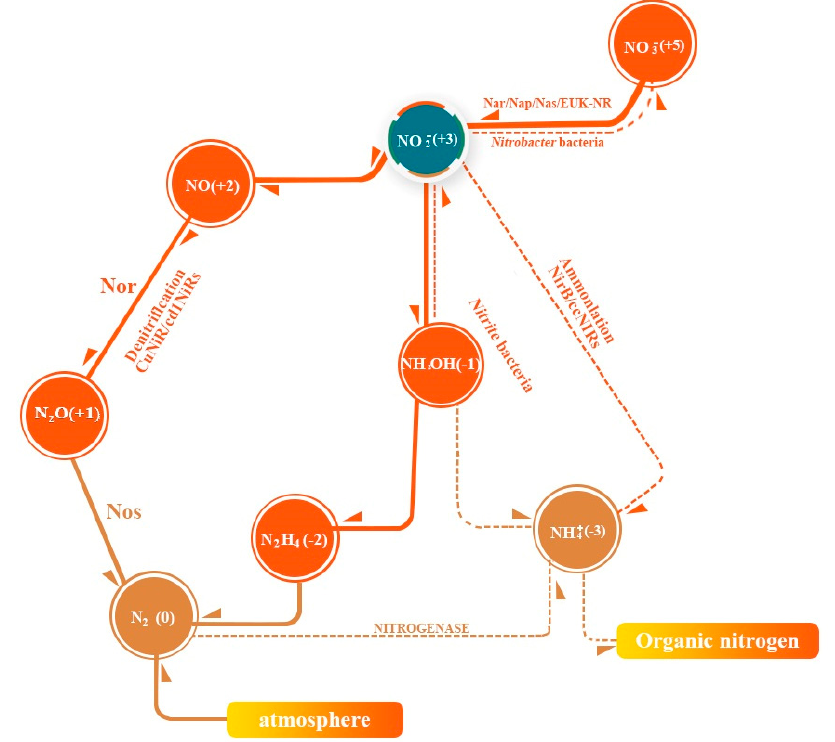
Figure 1. Biochemical cycling of nitrogen.